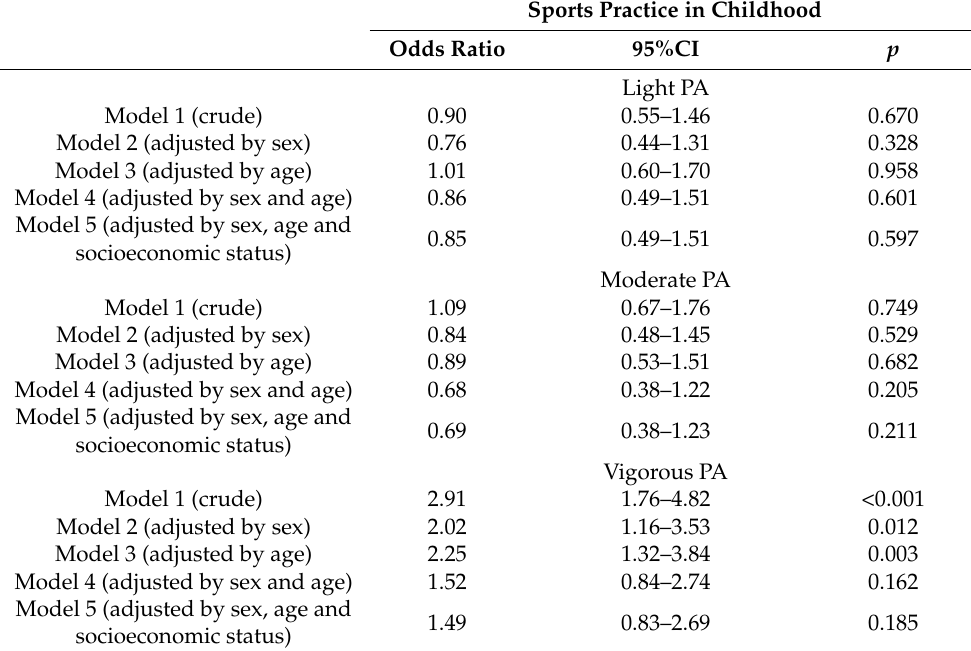
Table 2. Association between sports practice in childhood with different intensities of physical activity in adult life.